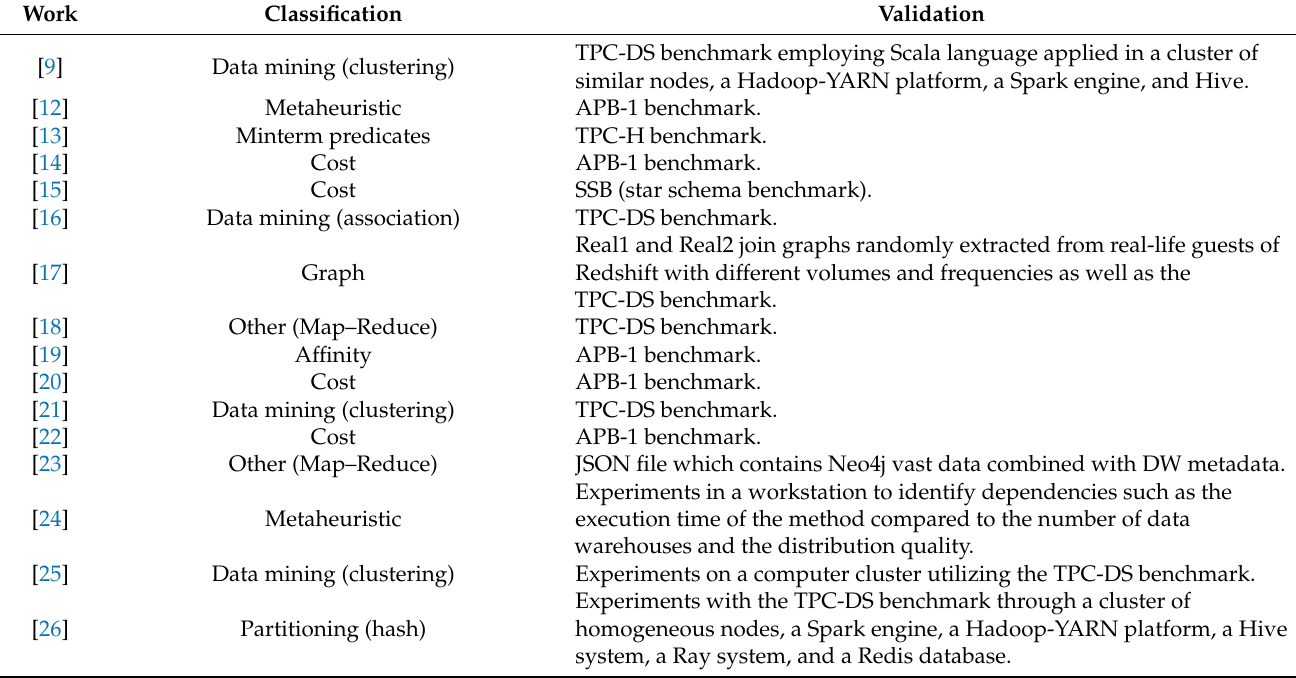
Table 1. Main characteristics of horizontal fragmentation